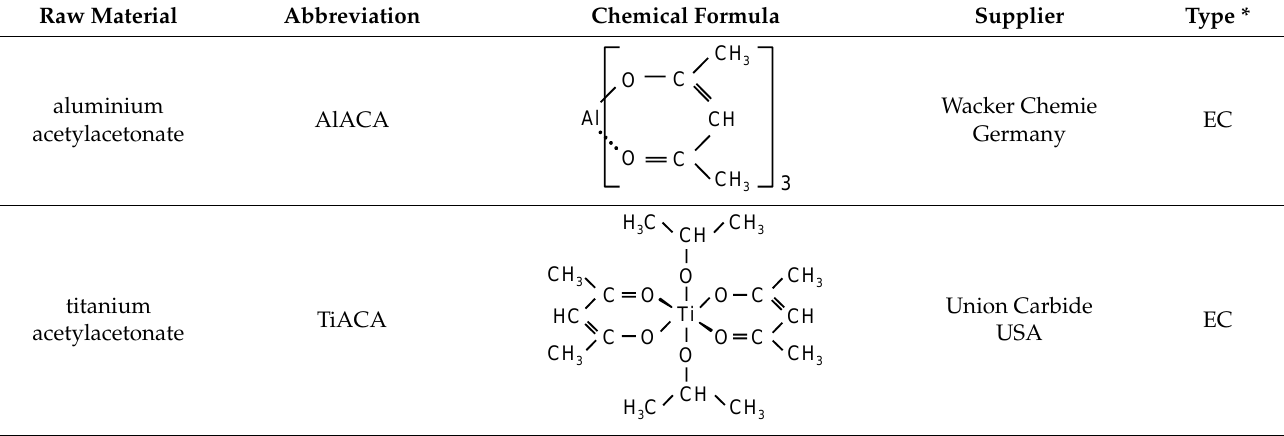
Table 1. Overview of the crosslinking agents used in the study.